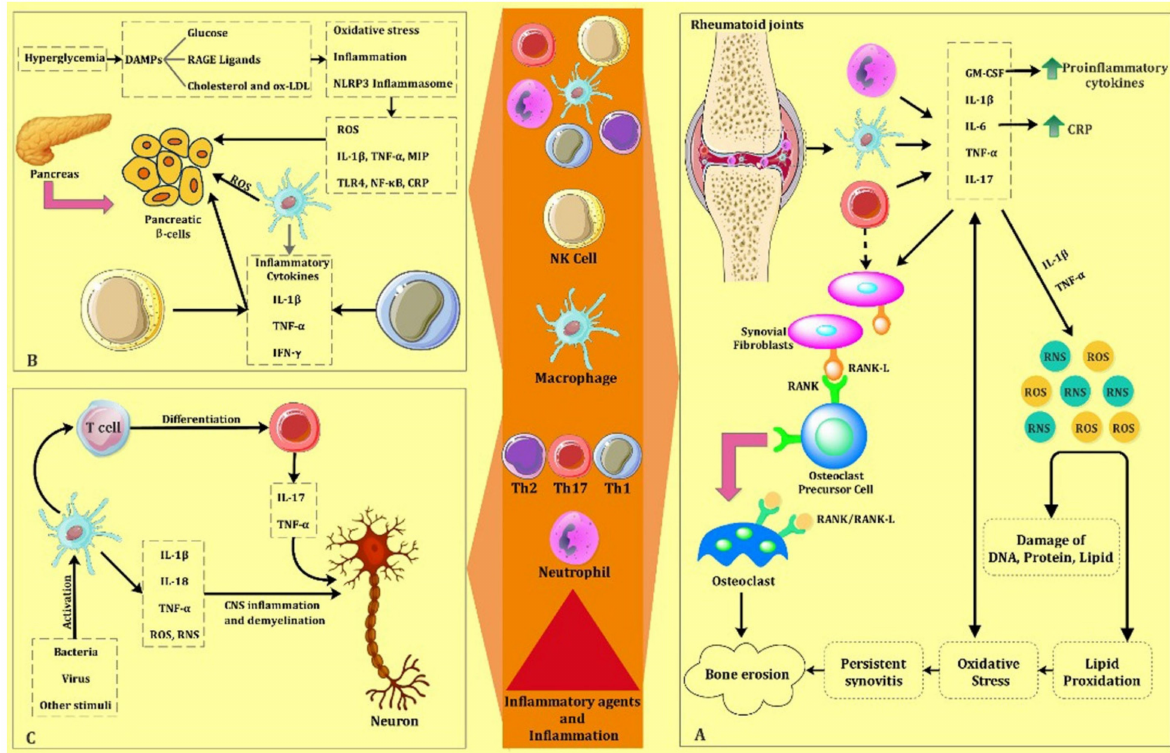
Figure 2. The role of immune cells and inflammatory cytokines in ( A ) rheumatoid arthritis, ( B ) diabetes, and ( C ) multiple sclerosis. A. Activated CD4 T-cells play an important role in RA pathogenesis and osteoclastogenesis by producing IL-17 cytokine, which subsequently induces RANKL on synovial fibroblasts and activates local inflammation, upregulating secretion of inflammatory cytokines such as TNF- α , IL-6, and IL-1 by synoviocytes, neutrophils, and macrophages. These inflammatory cytokines activate osteoclastogenesis by inducing RANKL on synovial fibroblasts or directly acting on osteoclast precursor cells. The increased cytokine production, especially TNF- and IL-1, stimulates synoviocytes, stress oxidation, and osteoclastogenesis. Moreover, Th17 cells also express RANKL on their cellular membrane, which partly contributes to the enhanced osteoclastogenesis. B. Various inflammatory cells involved in islet inflammation include macrophages as critical mediators via secreting TNF-a, IL-1b, and ROS. Autoreactive CD4 effector T-cells induce the inflammatory processes by release TNF- α , IL-1 β , and IFN- γ cytokines, leading to the recruitment of CD8+T cells and macrophages. Moreover, NK, DCs, and NKT cells may have a partial role in the whole process via inducing pro-inflammatory cytokines. C. Activated macrophages by pathogens resulted in the activation of the NF- κ B signaling pathway, subsequently inducing pro-inflammatory cytokines and free radical production. Moreover, the numbers of Th1 and Th17 cells and their cytokines such as IL-17, IL-1, IL-6, TNF- α , and IFN- γ are increased. Finally, the produced inflammatory and RNS/ROS mediators resulted in destroying the structure of the myelin sheath and